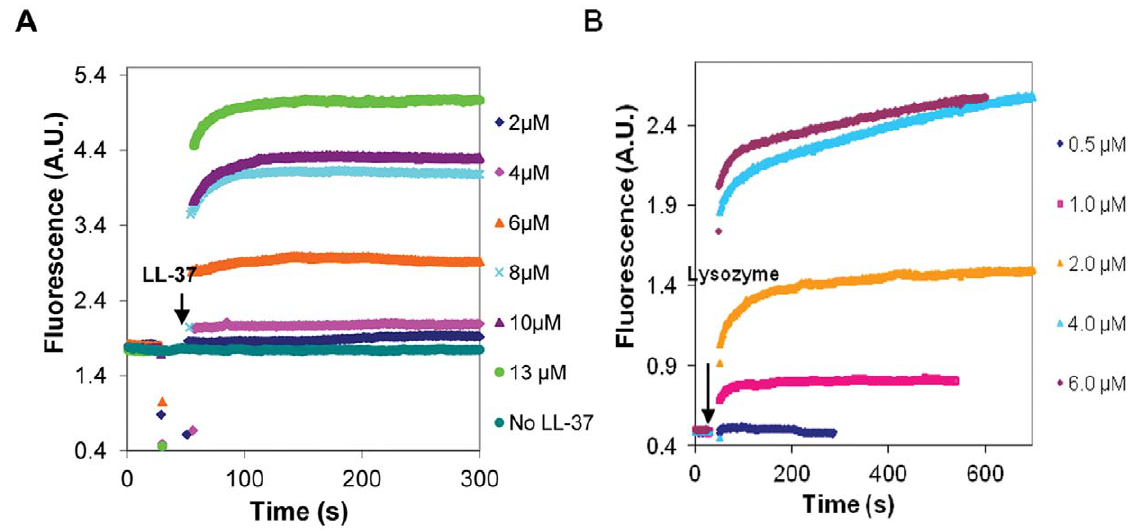
Figure 1. Polymerization of MgATP-G-actin by LL-37 and lysozyme at low ionic strength MgATP-G-buffer. LL-37 (A), or lysozyme (B) were added to pyrene labeled (10% labeling ratio) 2 m M MgATP-G-actin and the polymerization was followed by increase in pyrene fluorescence. Presented data are representative of three independent experiments.